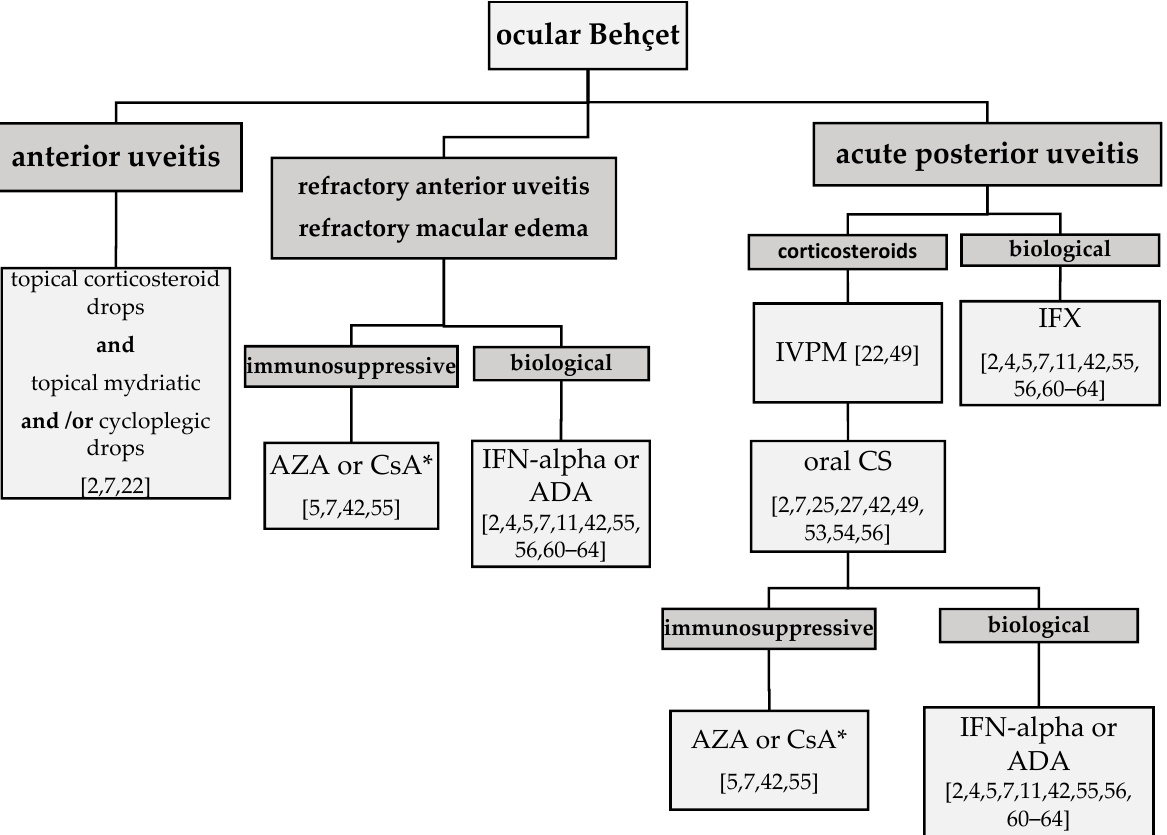
Figure 3. Proposed choice of therapeutic options, depending on the localization and severity of ocular inflammation. AZA—azathioprine; CsA—cyclosporine A (*)—NOT in the parenchymal neurological and ocular phenotype [42,57,58]; IFN-alpha—interferon alpha; ADA—adalimumab; IFX—infliximab; IVPM—intravenous pulse methyl prednisolone; (Copyright owner: Clinical Rheumatology, 2005); CS—corticosteroid.